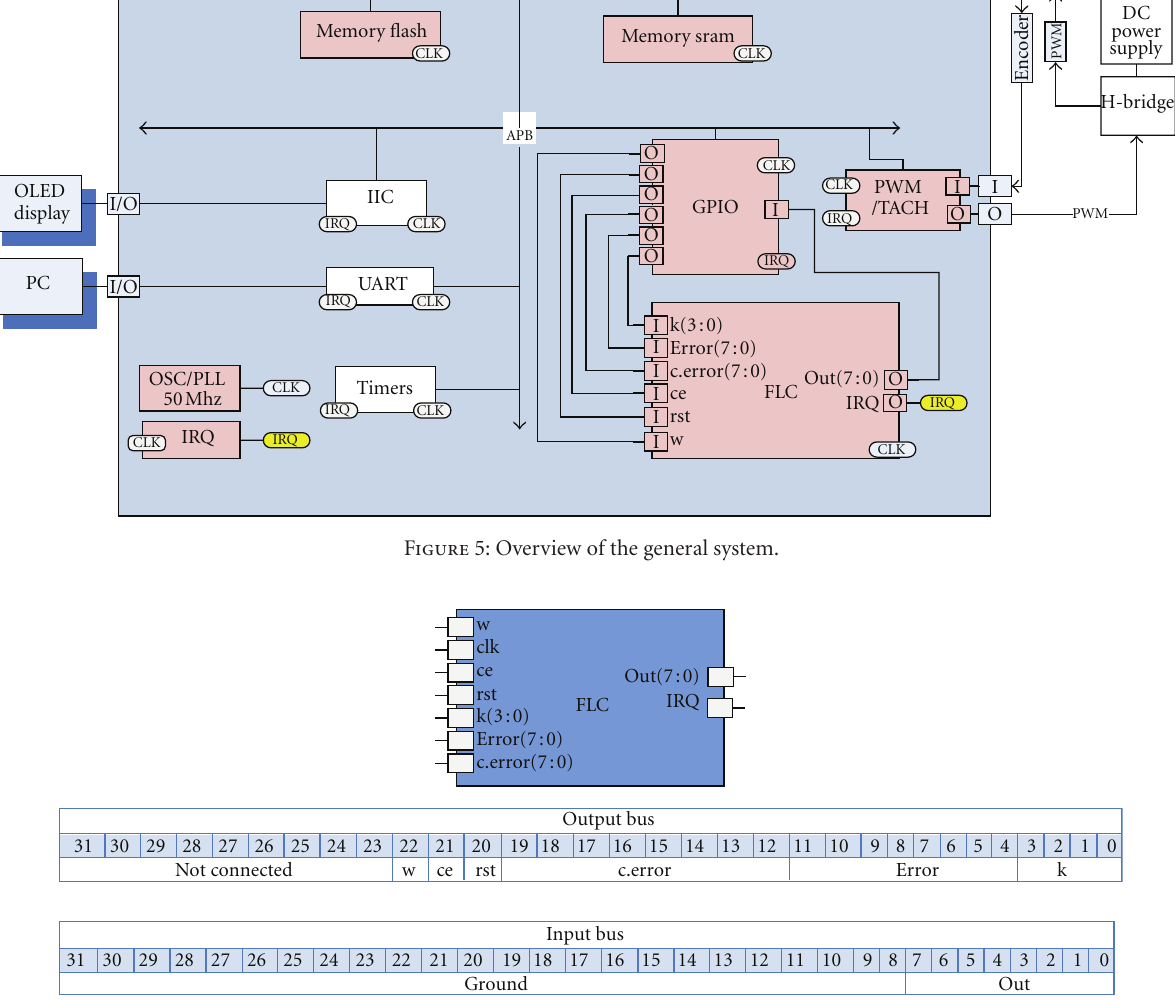
Figure 6: FLC entity and GPIO bus